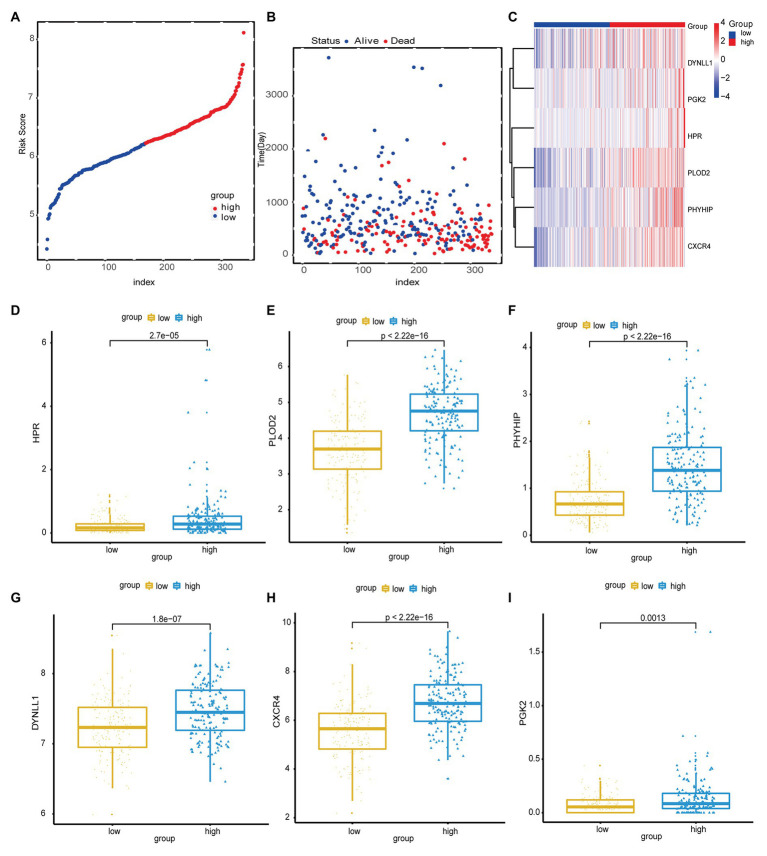
(A) Risk score distribution of high-risk group and low-risk group. (B) Scatter plot shows the survival status of GC patients with the increasing risk score. (C) Heat map shows the expression of autophagy-related genes (ARG) in the high- and low-risk score groups. (D-I) The boxplot displayed the expression of HPR, PLOD2, PHYHIP, DYNLL1, CXCR4, and PGK2 in the high- and low-risk score groups.